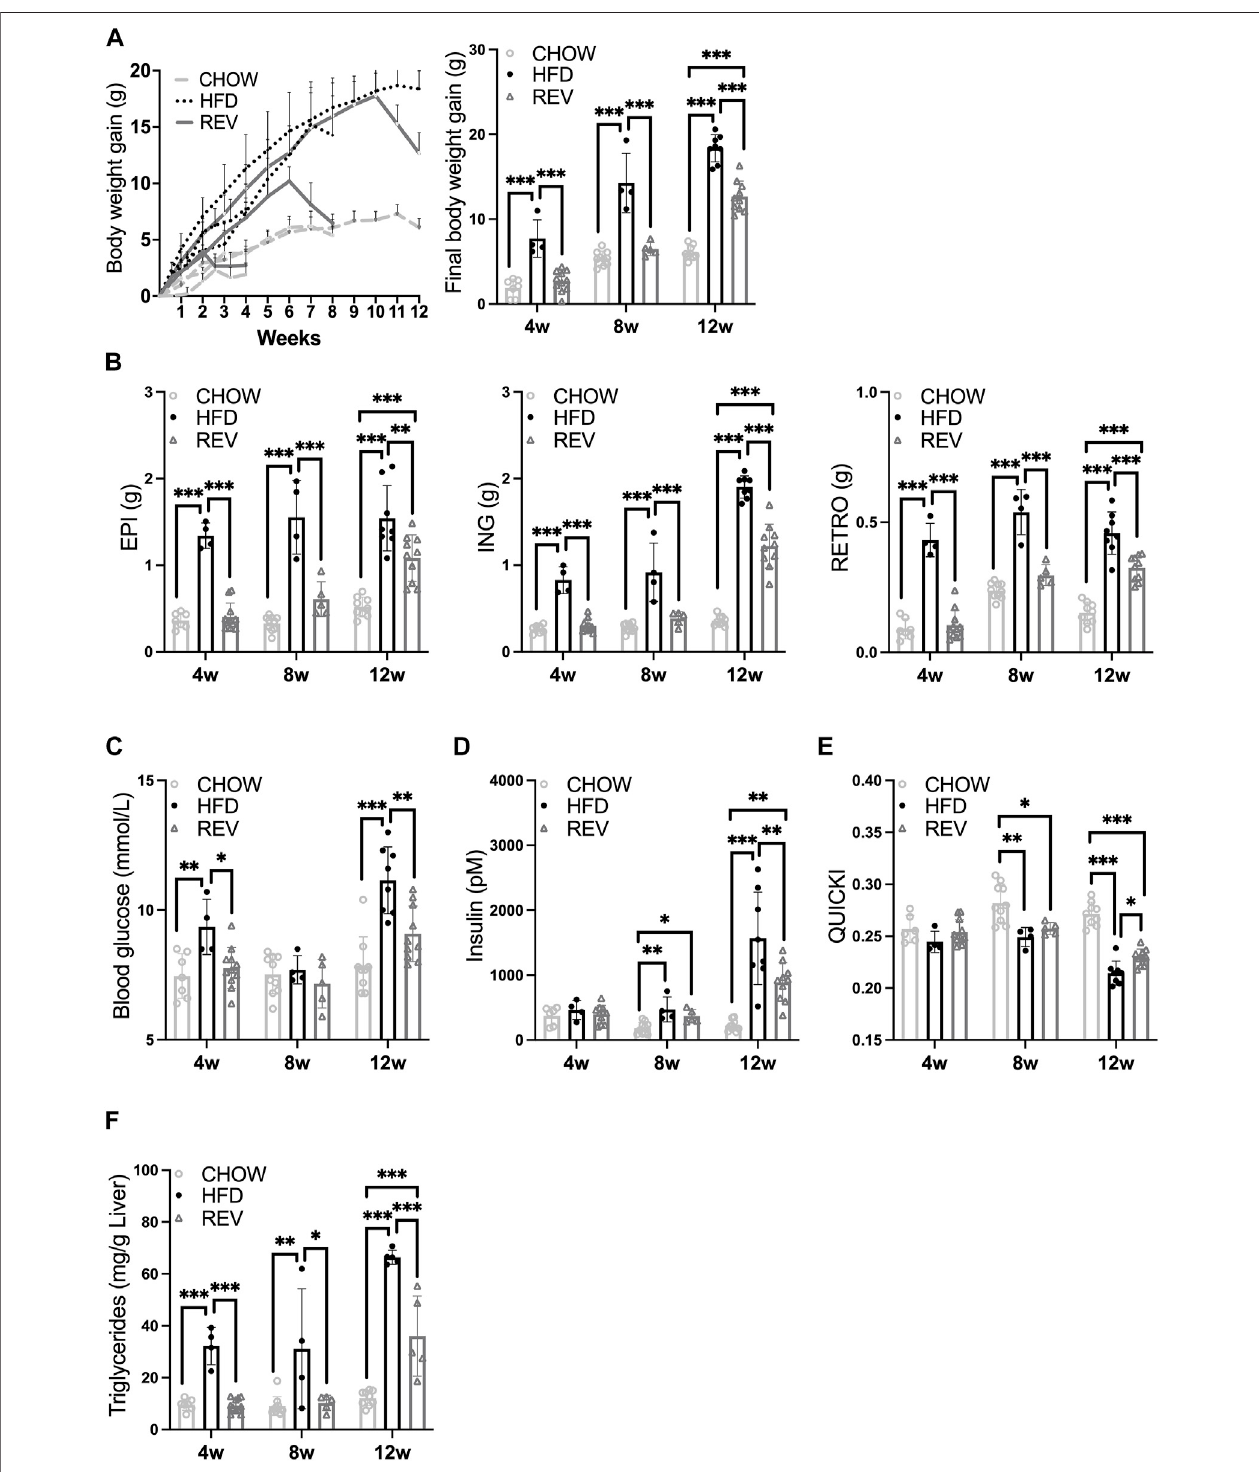
FIGURE 2 | Time-resolved analysis of systemic metabolic response and adipose tissue plasticity after switching from HFD to chow. Mice were subjected to diet intervention for4,8 or 12 weeks, each timepoint containingthe following three groups: CHOW,HFD and REV (see Figure 1 forstudy outline). Note, the same datafrom HFD aredisplayedin Figure1 . (A) Body-weight gainwasmonitored weekly(left panel) and at termination (rightpanel). (B) Final fatdepot weight (EPI, ING,and RETRO). (C) Blood glucose (mM), (D) serum insulin (pM) and corresponding (E) QUICKI. (F) Liver triglycerides (mg/g liver). Data are displayed as mean±SD and one-way ANOVA, Tukey ’ s post-hoc test, was used as statistical analysis of differences between CHOW, HFD and REV for each time point (4, 8, and 12w). Signi fi cance was determined according to * p ≤ 0.05, ** p ≤ 0.01 and *** p ≤ 0.001.